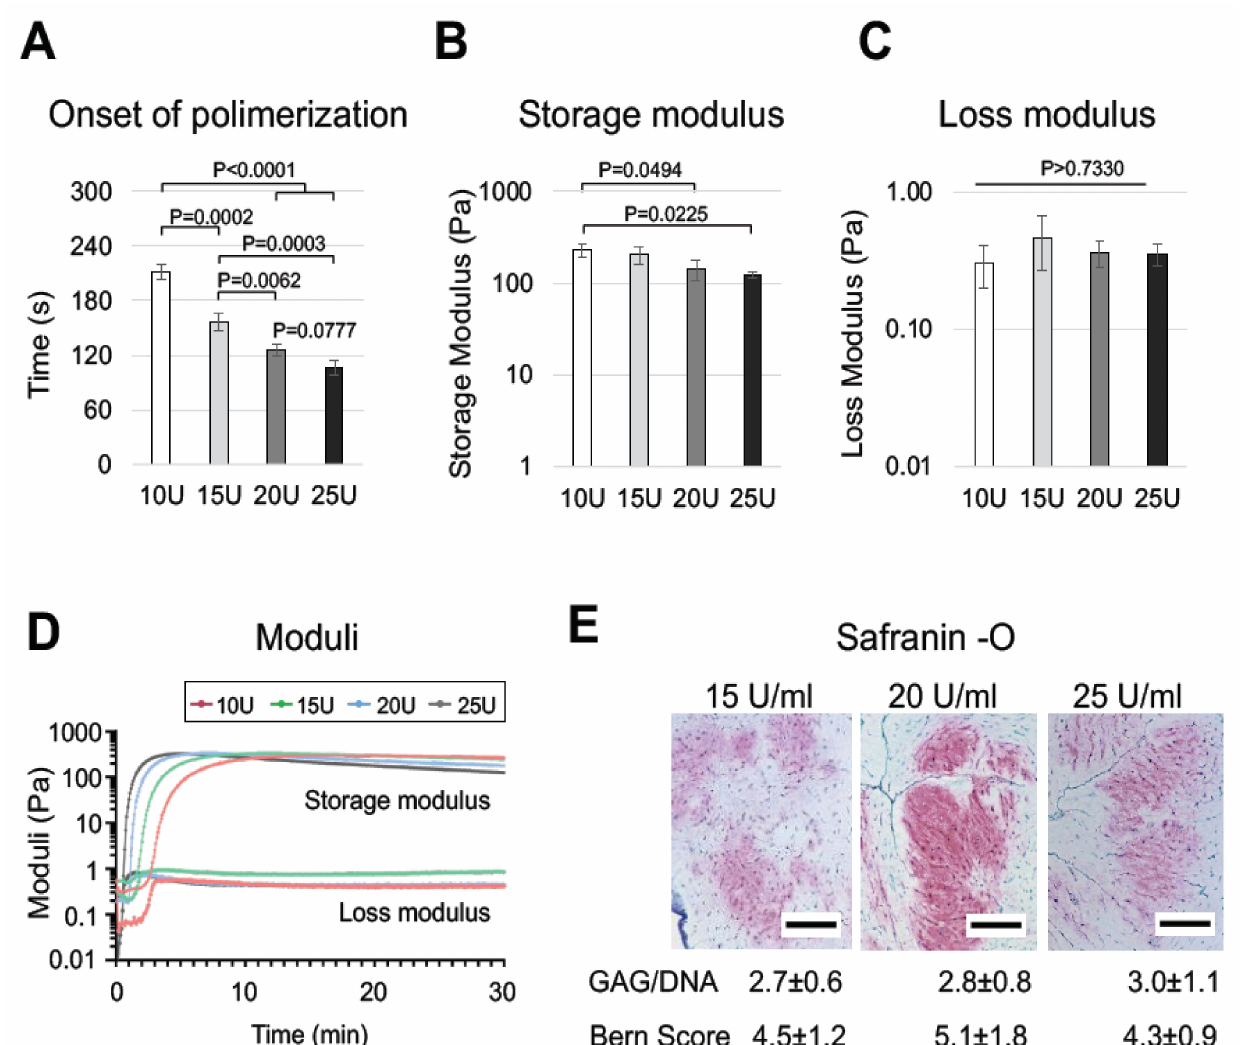
Figure 6. Optimization of PEG hydrogel constructs for clinical use. ( A – C ) Generation kinetics of 1.5% PEG gels with different concentrations of factor XIII used for polymerization (10, 15, 20 and 25 U/mL): onset of gelation ( A ), storage ( B ) and loss ( C ) modulus, generation kinetics curve of storage and loss moduli ( D ). ( E ) Safranin-O staining of constructs generated using 15, 20 and 25 U/mL of factor XIII, GAG/DNA contents and Bern score grading of the corresponding samples. Values are mean ± SD of results of three replicate samples. Scale bars = 100 µ